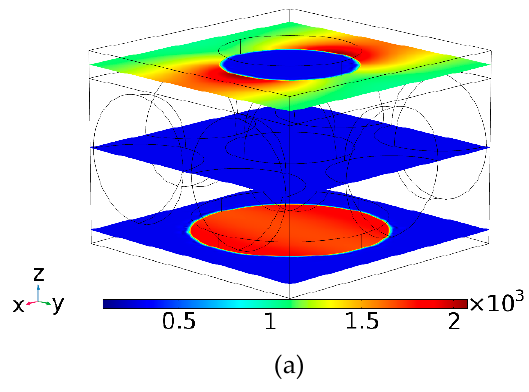
Figure 7. Temperature distribution in Kelvins ( o K) after 1 ns at peak electromagnetic absorption wavelength of ( a ) λ = 1.24 microns and ( b ) λ = 1.33 microns when the gap is filled with air/silica